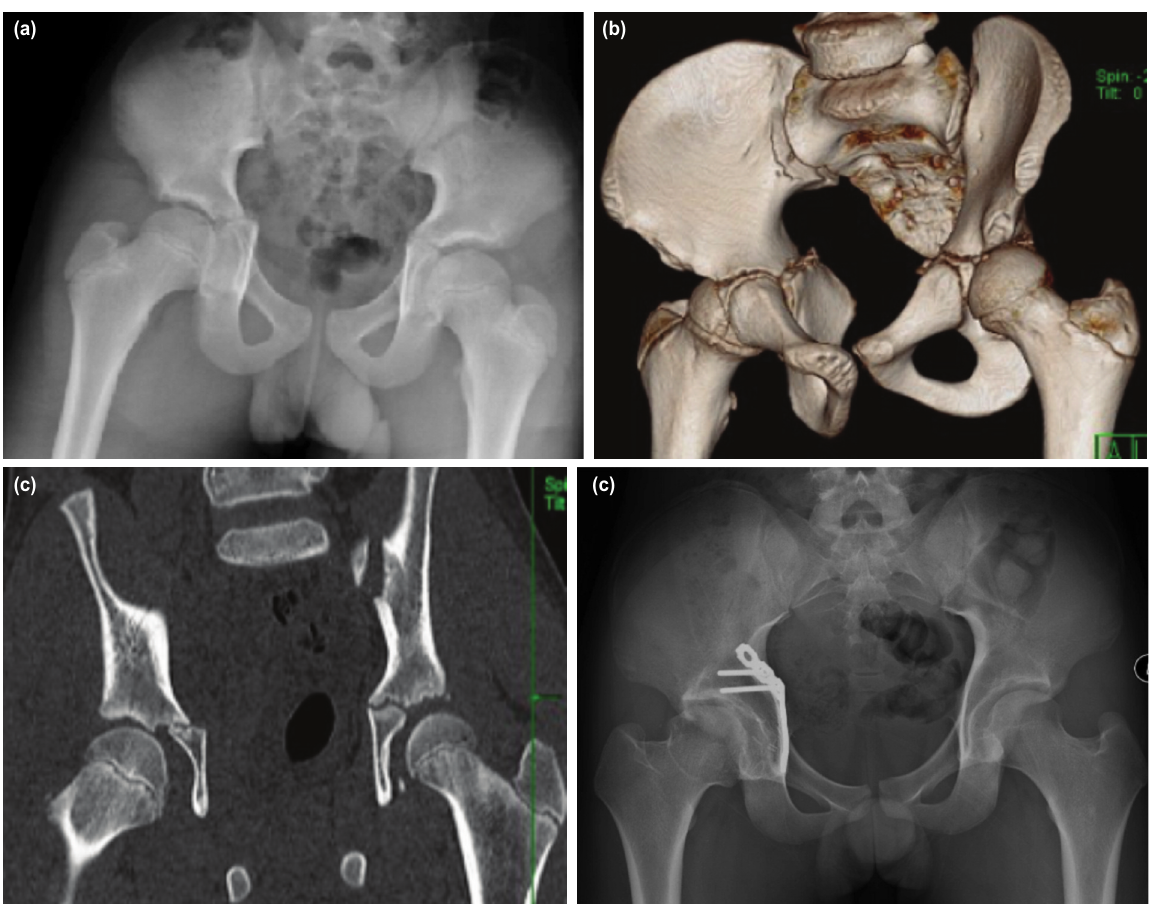
A 13-year-old boy pillion rider sustained a displaced trans-physeal fracture over right acetabulum. (a) Initial pelvis AP radiographs Fig. 2: shows a displaced transphyseal acetabular fracture. (b) 3D CT image of pelvis depicted the acetabular physeal involvement of fracture. (c) AP image of CT scan. (d) Stabilisation was done using buttress quadrilateral plate with screws avoiding the acetabular physis. (e) There is evidence of femoral head avascular necrosis and subsequently well-remodelled six years after injury (e). Both modified Merle d'Aubigné-Postel and HHS functional outcome are